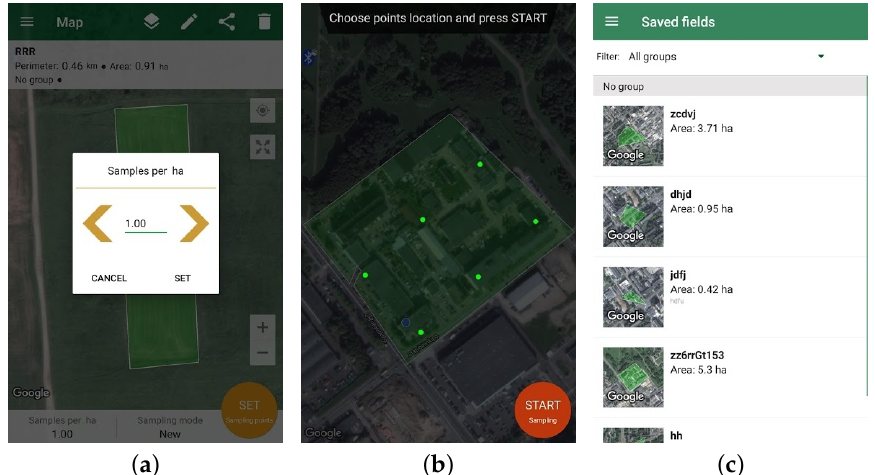
Figure 33. Soil Sampler: ( a ) Setting the desired number of samples; ( b ) Sample location visualization; ( c ) History of saved fields.